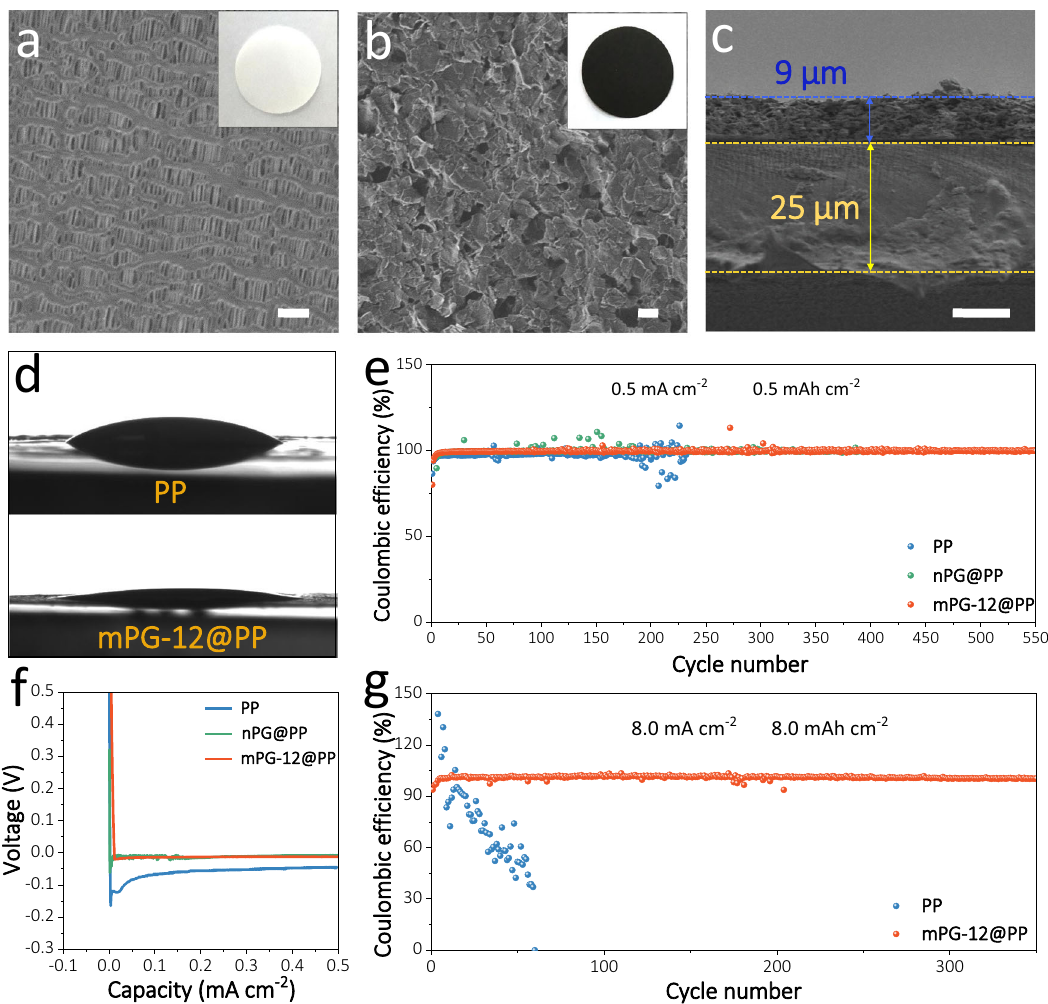
Fig. 4 Characterization and performance of mPG-12@PP separator for Na || Cu cells. a Top-view SEM image and photograph (inset) of bare PP separator. b Top-view SEM image and photograph (inset) of mPG-12@PP separator. c Cross-section SEM image of mPG-12@PP separator. d Contact angles of the electrolyte on bare PP (top) and mPG-12@PP (bottom) separators. e Coulombic ef fi ciencies of Na || Cu cells with mPG-12@PP, nPG@PP and PP separators tested at 0.5 mA cm – 2 , 0.5 mAh cm – 2 . f Voltage-capacity curves during Na nucleation with different separators. g Coulombic ef fi ciencies of Na || Cu cells with mPG-12@PP and PP separators measured at 8.0 mA cm – 2 , 8.0 mAh cm – 2 . Scale bars: a , b 1 μ m, and c 10 μ